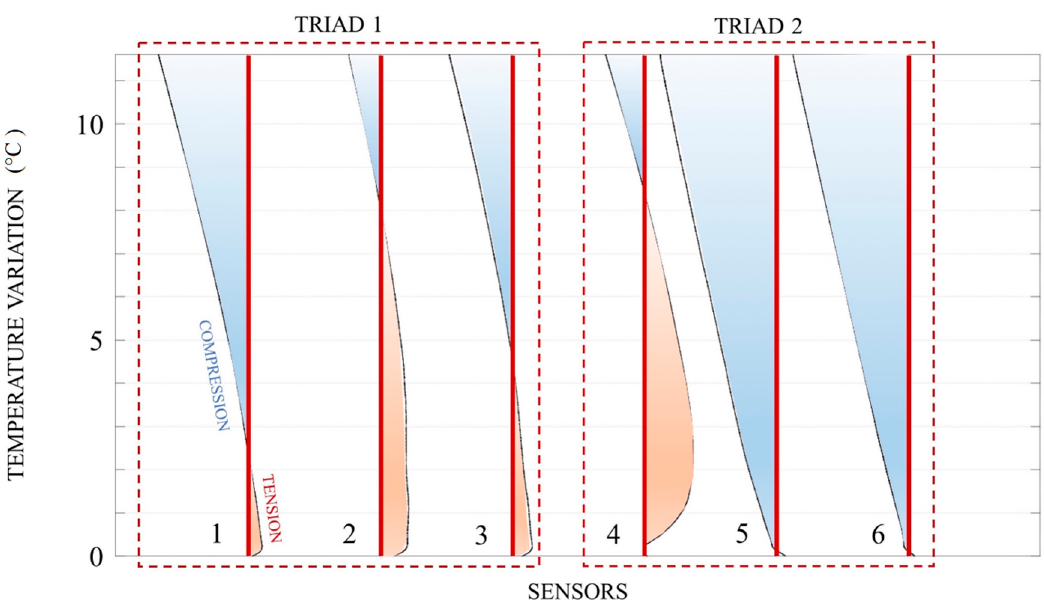
Figure 5. Temperature rise vs. longitudinal strain, where the longitudinal strain is placed on the horizontal axis; Triad 1 (sensors 1–3) registered an increment in tension (positive, highlighted in red), whereas Triad 2 recorded concurrent expansion in the upper portion of the tube (sensor 4) and contraction (negative, highlighted in blue) in the lower one (sensors 5–6).